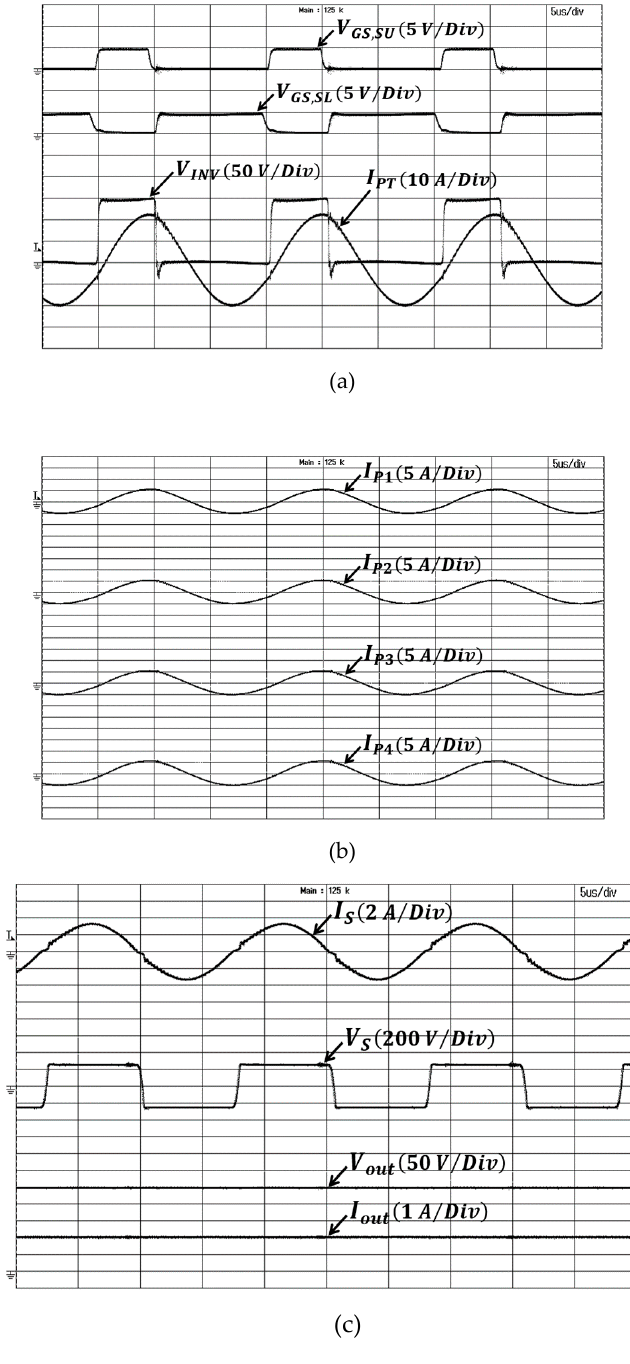
Figure 17. Experimental waveforms of the system under normal mode operation: ( a ) Gate signals of the inverter’s main switches (V GS,SU and V GS,SL ), inverter voltage (V INV ), and total primary current (I PT ); ( b ) Current in each transmitter coil (I P1 –I P4 ); ( c ) Secondary voltage (V S ), secondary current (I S ), output voltage (V out ), and output current (I out ).